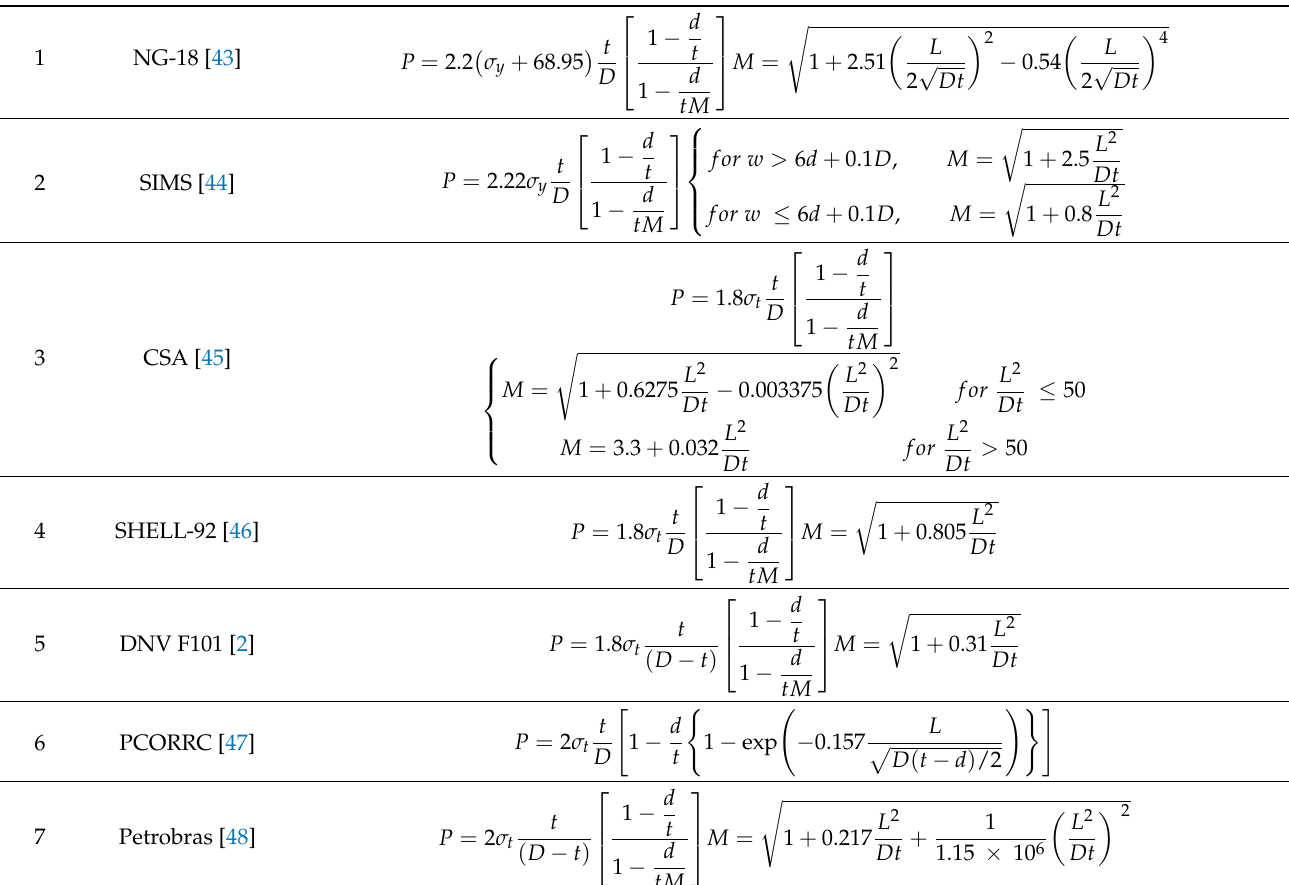
Table A1. Burst Strength Models of Corroded